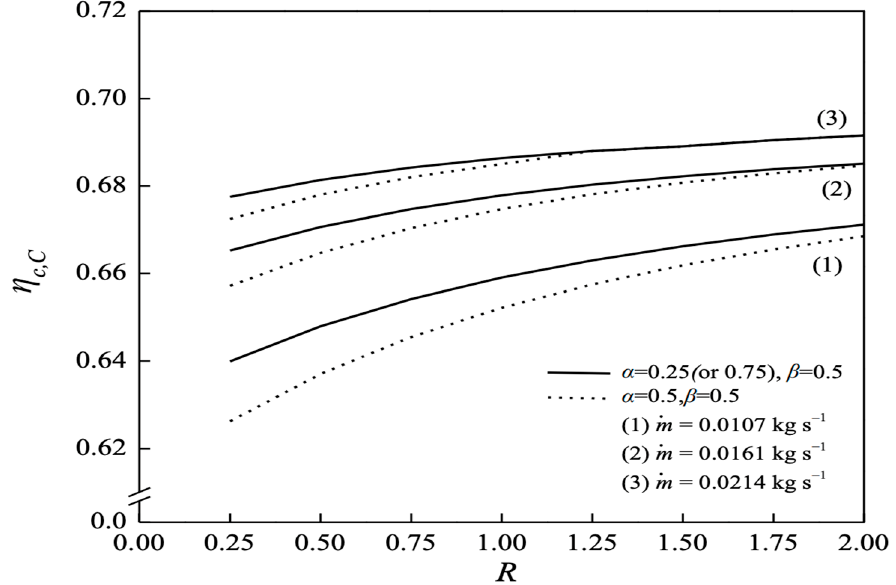
Figure 11. Effects of aspect ratios and inlet air mass flow rates on the collector thermal efficiency.